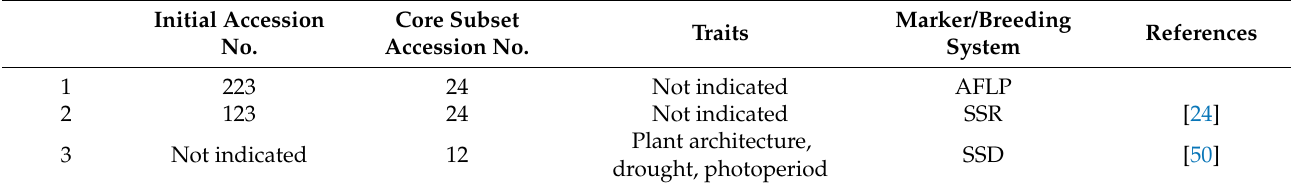
Table 2. Some of the developed core sets of bambara